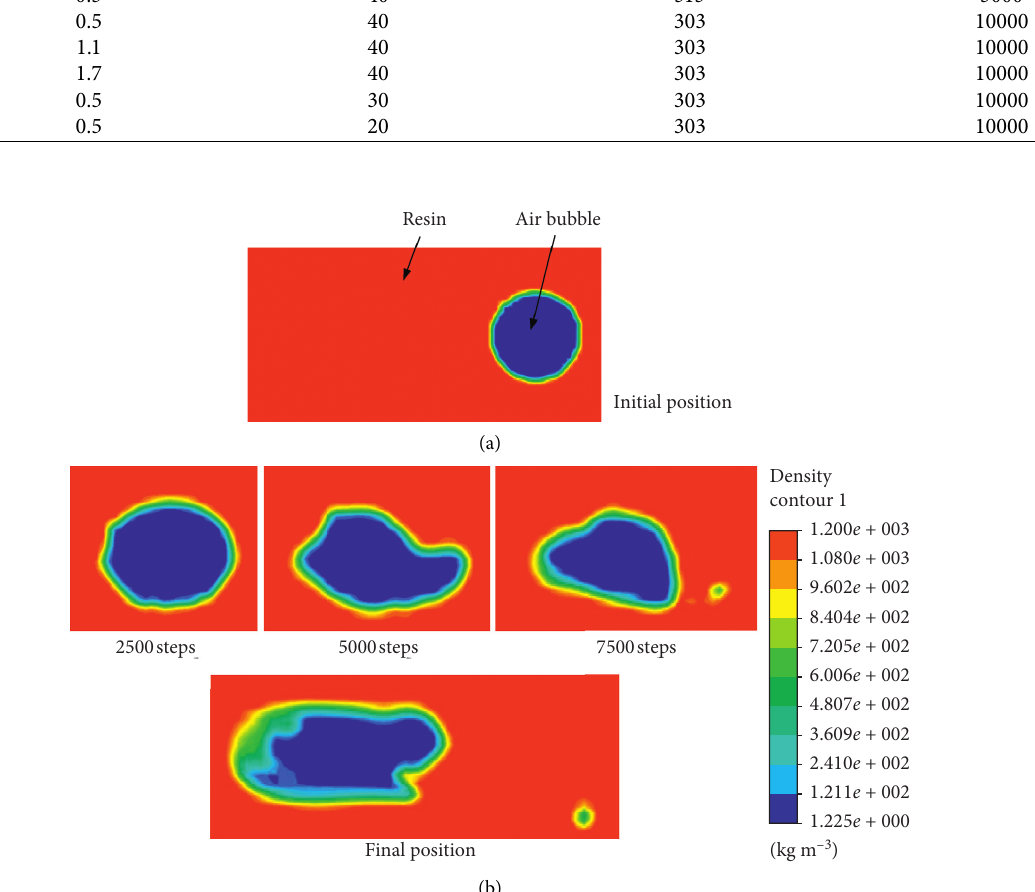
Figure 3: Fluid-gas coupling model and simulations. (a) Fluid-gas coupling initial model. (b) The evolution behaviors of the bubble in the fluid at the laying pressure of 0.5MPa, the laying speed of 40 mm/s, and the preheating temperature of 323K.